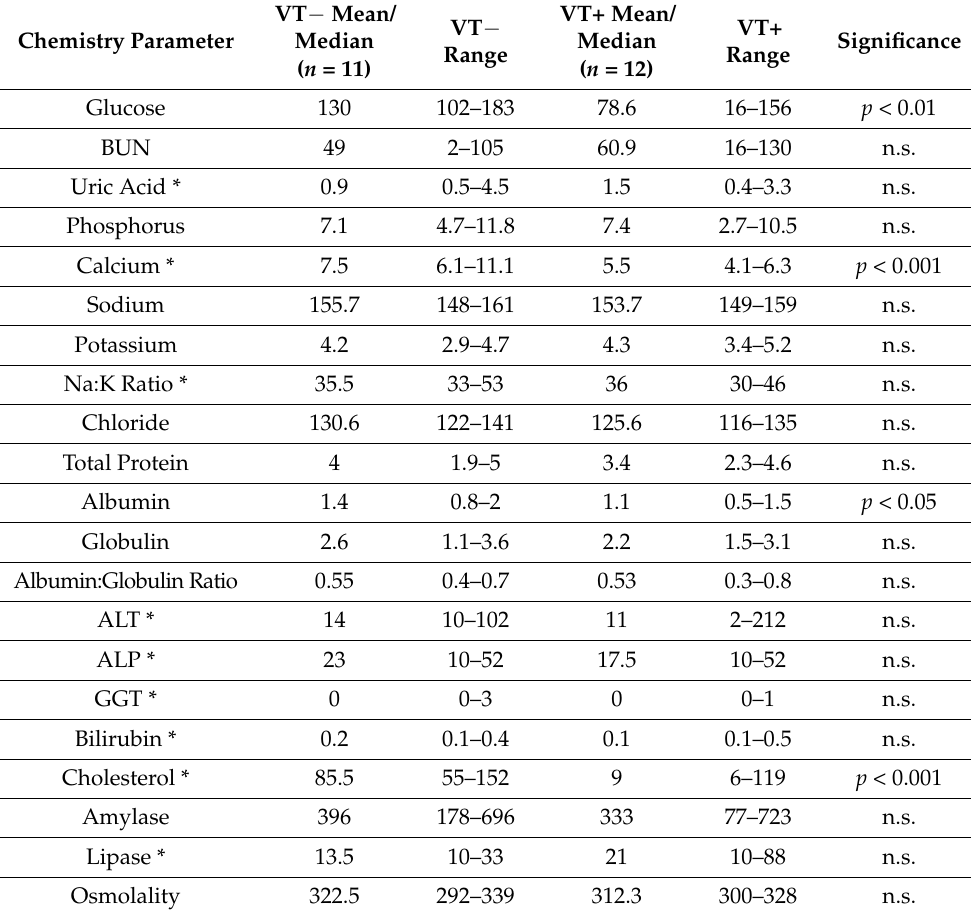
Table 1. Intake blood chemistry values for turtles taken into the GLNC rehabilitation facility. Glucose, calcium, albumin, and cholesterol values in VT − turtles were significantly different than VT+ values ( p < 0.05). No other blood chemistry values were significantly different ( p > 0.05). * Medians were used for these chemistries due to non-normalized